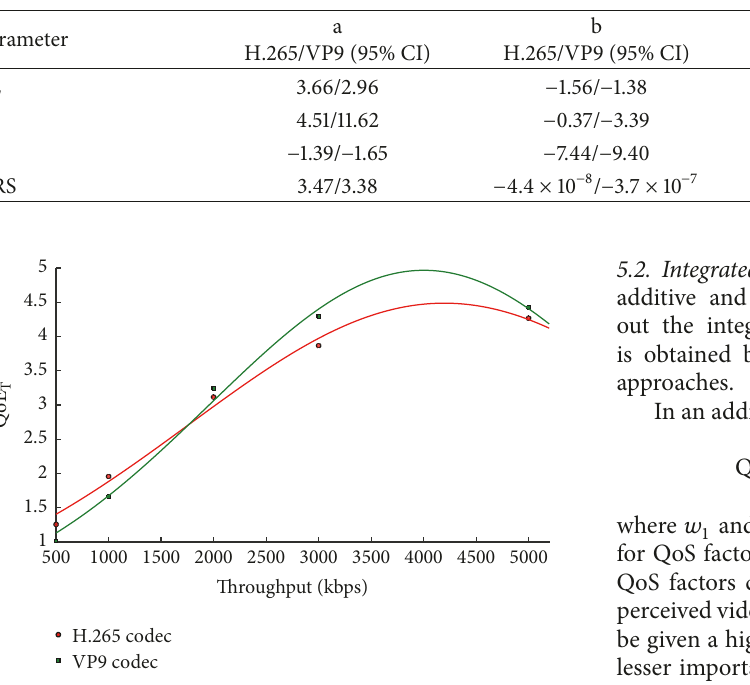
Figure9:Relationshipbetweenthroughput(Kbps)andQoE subjective test).